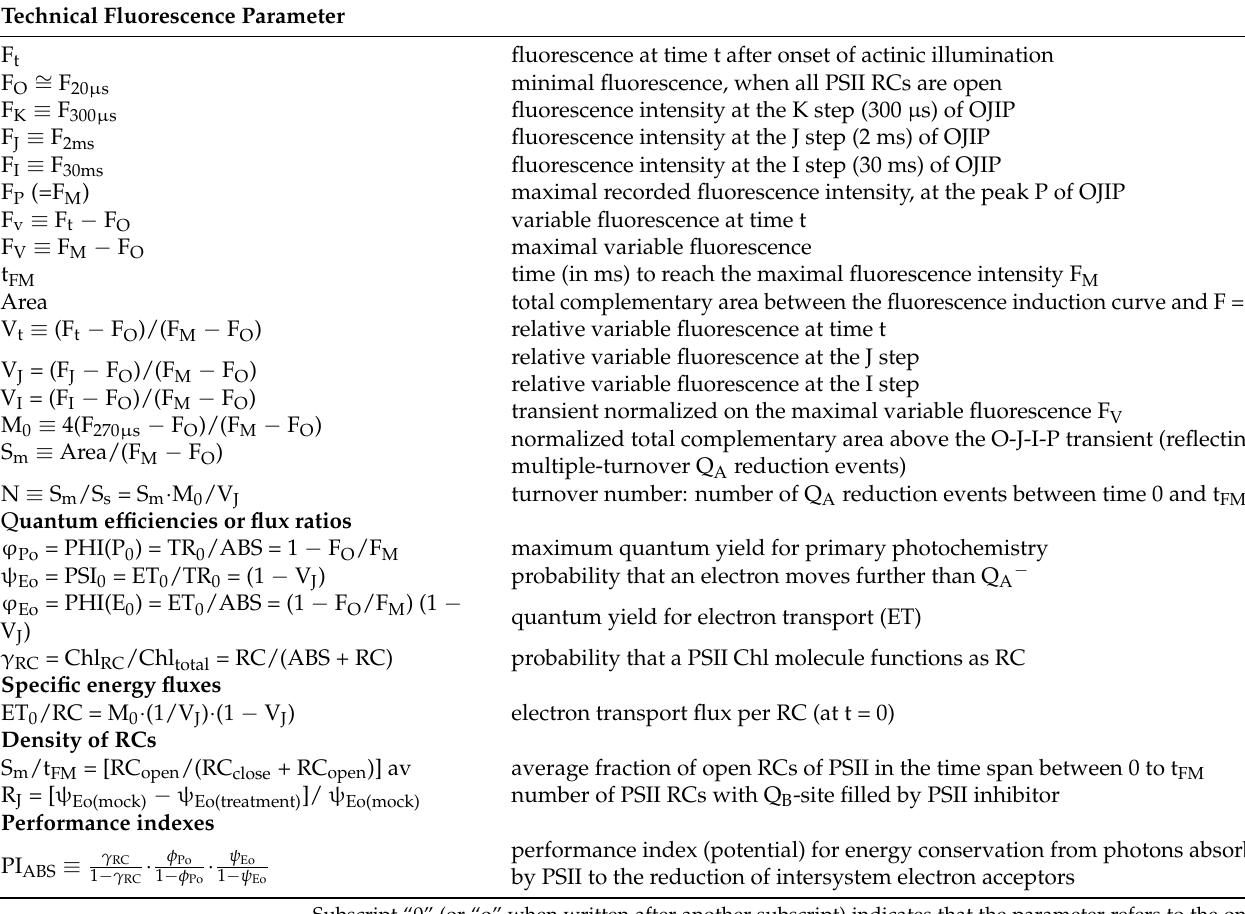
Table 2. Formulae and explanation of technical data of the OJIP curves and the selected JIP test parameters used in this